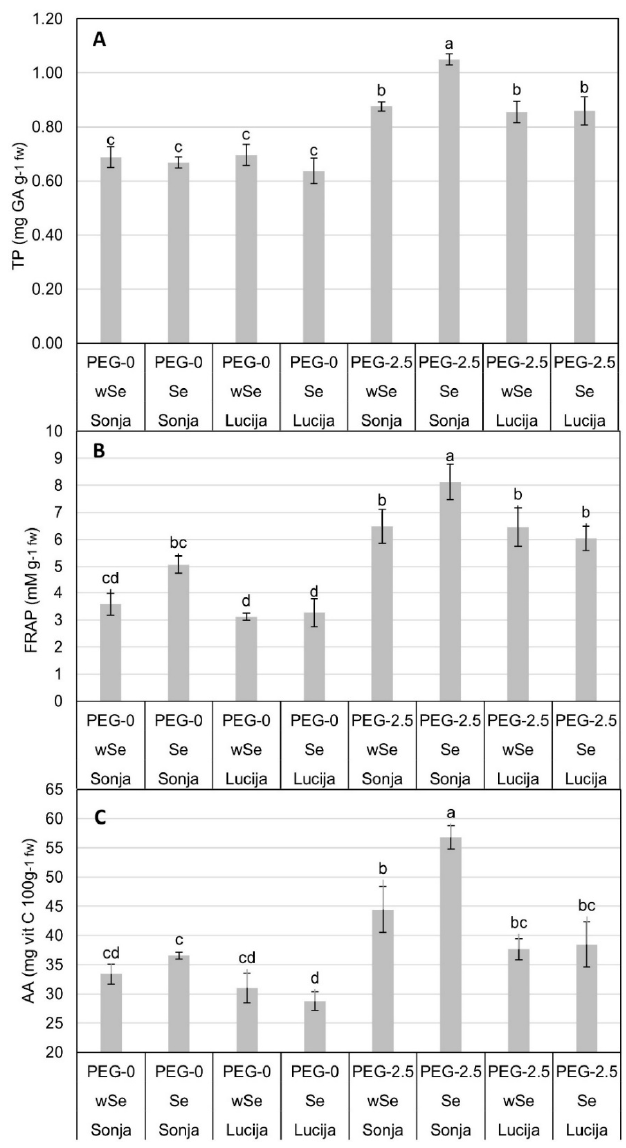
Figure 2. Means and standard errors of mean (SEM) for total phenolic content ( A ), FRAP (total antioxidant activity) ( B ) and AA (ascorbic acid) ( C ). Significance of effects is denoted with different letters at α = 0.05